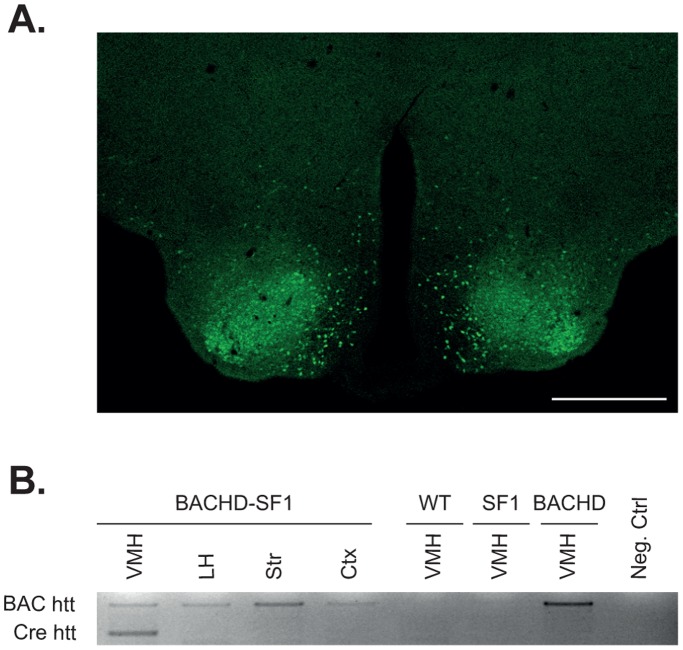
Validation of Cre-excision in SF1-expressing neurons in the VMH.A. SF1 mice were crossed with ROSA-EYFP mice and the expression in SF1 neurons was validated using GFP immunofluorescence. GFP immunoreactive cells were primarily clustered in the VMH. Scale bar represents 500 µm. B. Gel showing Cre recombination as validated by PCR of several brain regions from BACHD-SF1, BACHD, SF1 and WT mice. The presence of the unrecombined mutant HTT allele (1050 bp) was detected in all the BACHD-SF1 and BACHD samples while the recombined mutant HTT allele (600 bp) was only detected in VMH brain samples from the BACHD-SF1 mice.